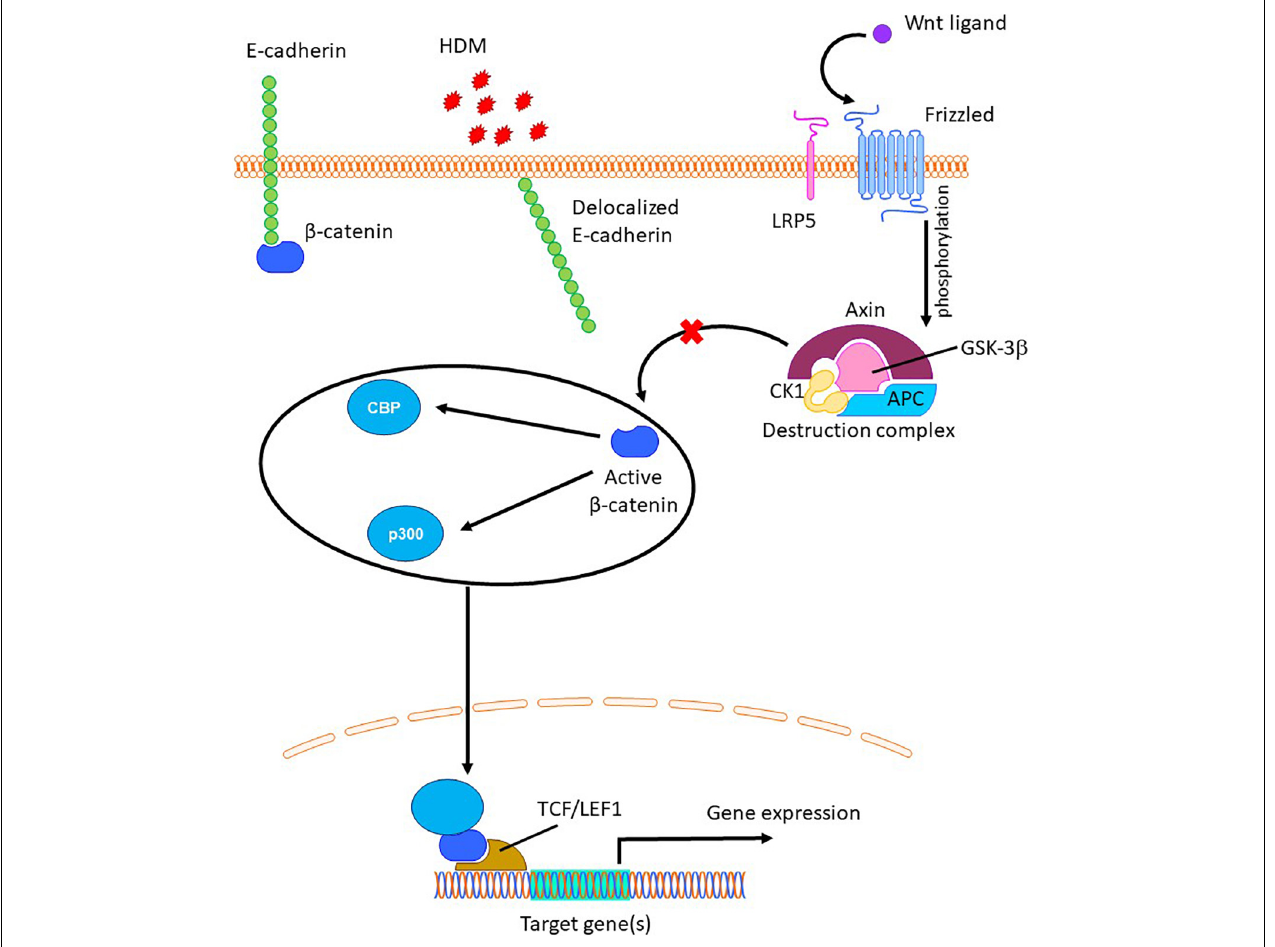
FIGURE 1 | The role of β -catenin in regulation of gene expression. Allergens like house dust mite (HDM) can delocalize junctional E-cadherin (Post et al., 2012), resulting in the release of β -catenin into cytoplasm, where is targeted for proteolytic degradation by the destruction complex (Valenta et al., 2012). Upon Wnt ligand mediated phosphorylation and inactivation of GSK-3 β , cytosolic β -catenin escapes from the destruction complex, translocates to the nucleus and binds to TCF/LEF group of transcriptional factors and other co-activators such as CBP and p300, resulting transcription of target genes (Valenta et al.,